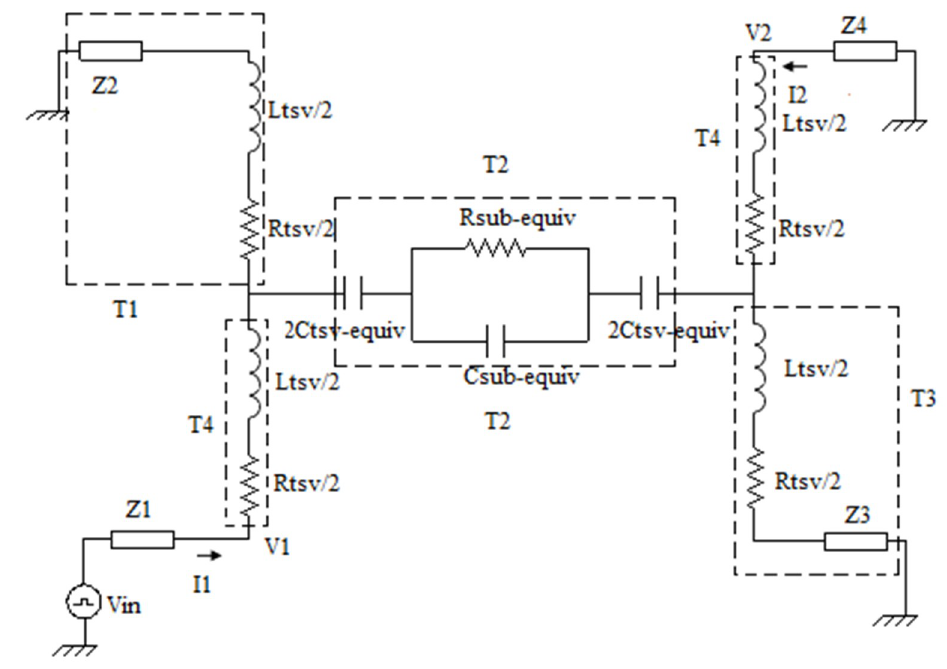
Figure 2. Lumped circuit model of TSV–TSV noise coupling.